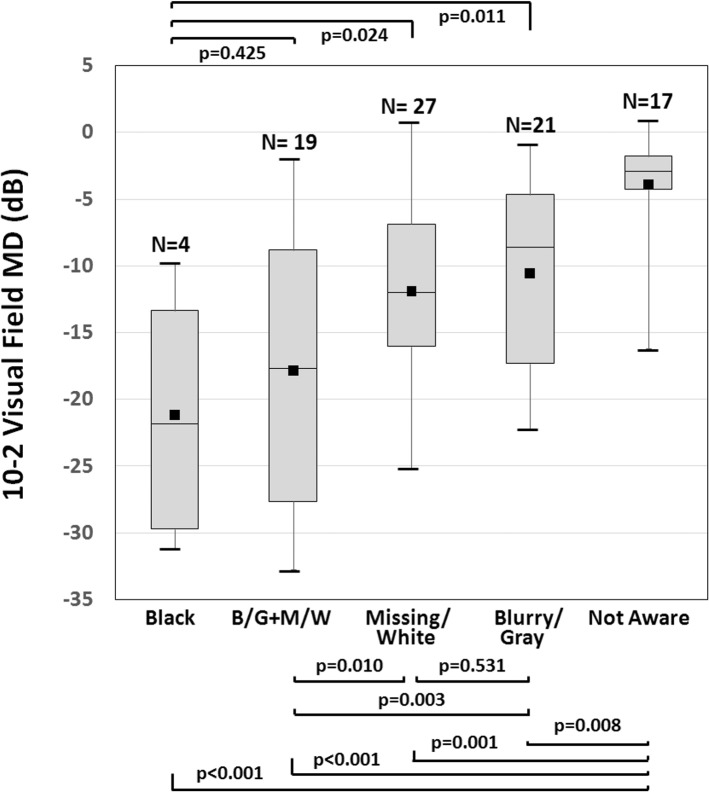
Box-and-whisker plots of 10–2 visual field mean deviation (MD) according to the 5 combinations of descriptor categories of the eye (4 descriptor category classification in Table 1).The number above the bar graphs represents the number of eyes in that combination (a total of 88 eyes). The horizontal line within the box indicates the median, upper and lower boundaries of the box indicate the 75th and 25th percentiles, and the whiskers indicate the maximum and minimum values. The black squares in the boxes indicate the mean. ‘B/G+M/W’ indicates combination of ‘Blurry/Gray’ and ‘Missing/White’ descriptor categories. Overall p value <0.001. Asterisks indicate p values <0.05.